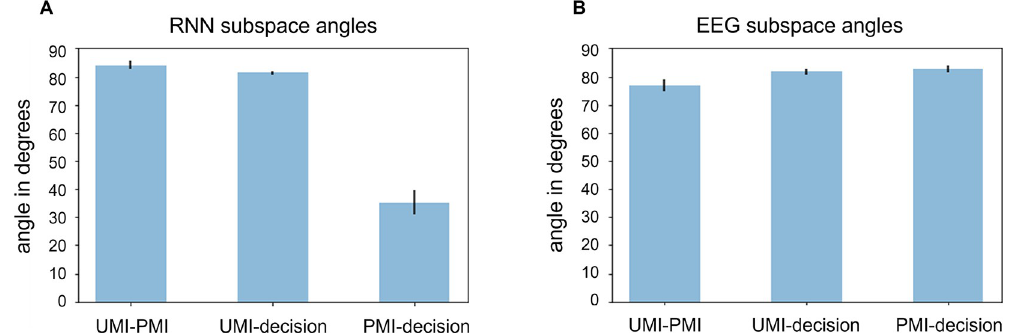
Fig 7. Angles between UMI, PMI and decision subspaces for (A) 60D RNN and (B) EEG data. Black bars indicate standard error of the mean.